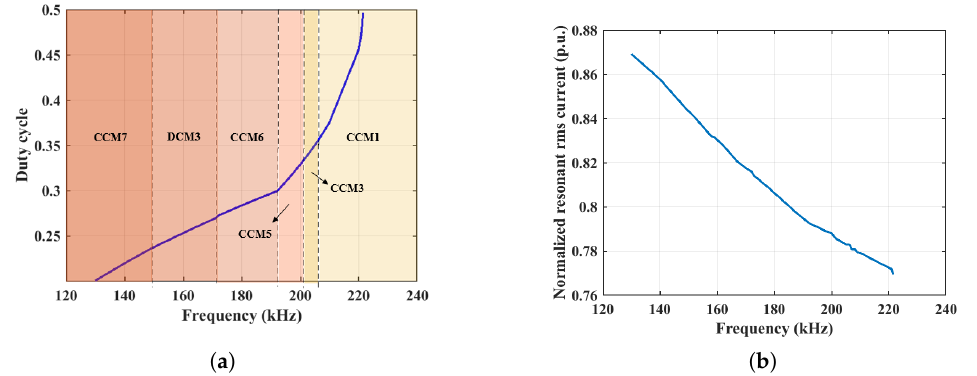
Figure 13. Comparison of operating points: ( a ) Different operating points (f sw ,D) for 160 V full load condition; ( b ) Resonant rms current at the operating points for 160 V full load condition.